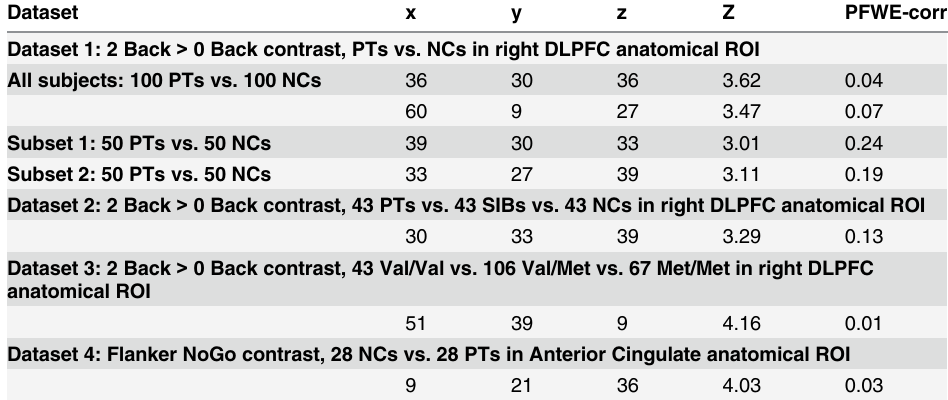
Table 2. Group difference results from the voxel-wise analysis within anatomical ROIs. Dataset x